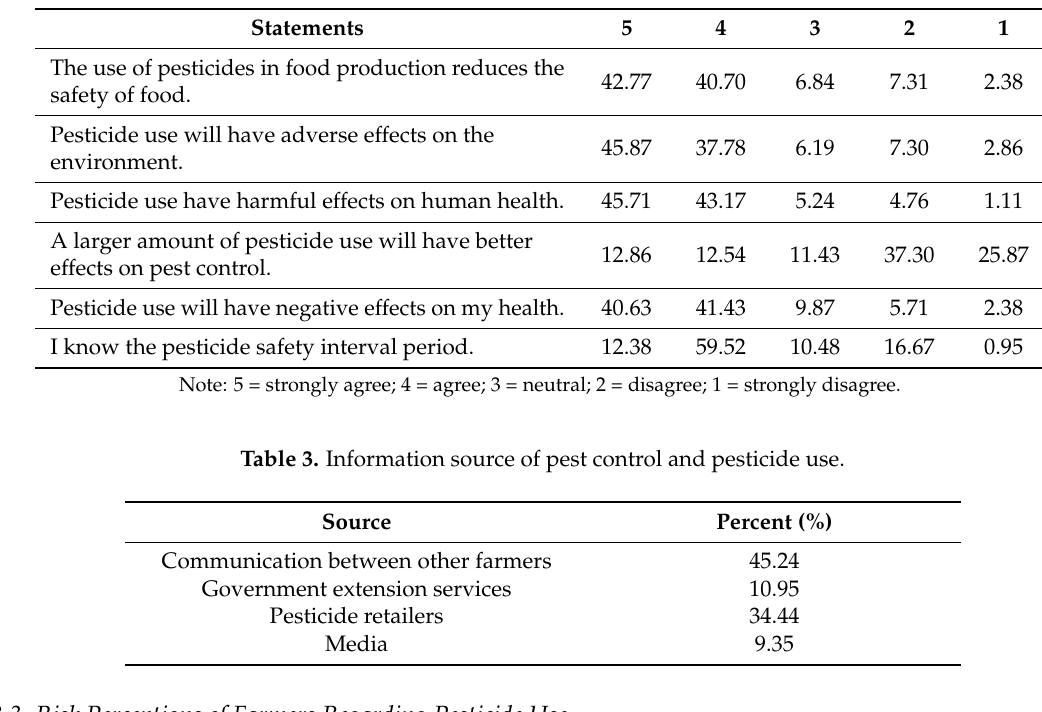
Table 2. Respondents’ perceptions on pesticide use.